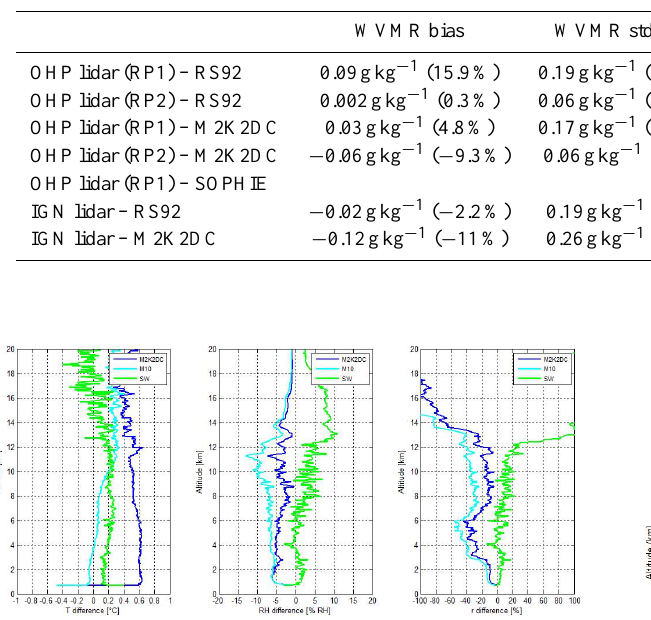
Fig. 10. Comparison of mean temperature, relative humid- ity, and WVMR profiles from M2K2DC, M10, and SW with respect to RS92. (Left) Difference of temperature measure- ments. (Middle) Difference of relative humidity measurements. (Right) Relative difference of WVMR measurements (sonde – RS92)/(sonde + RS92)*200 (%).